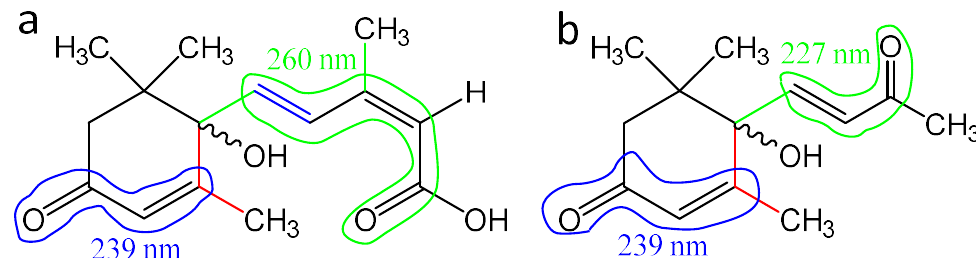
Figure 6. Systems of double bonds in ABA ( a ) and dehydrovomipholiol ( b ) which determine the base value of λ 0 for calculating the maximum UV absorption wavelength.